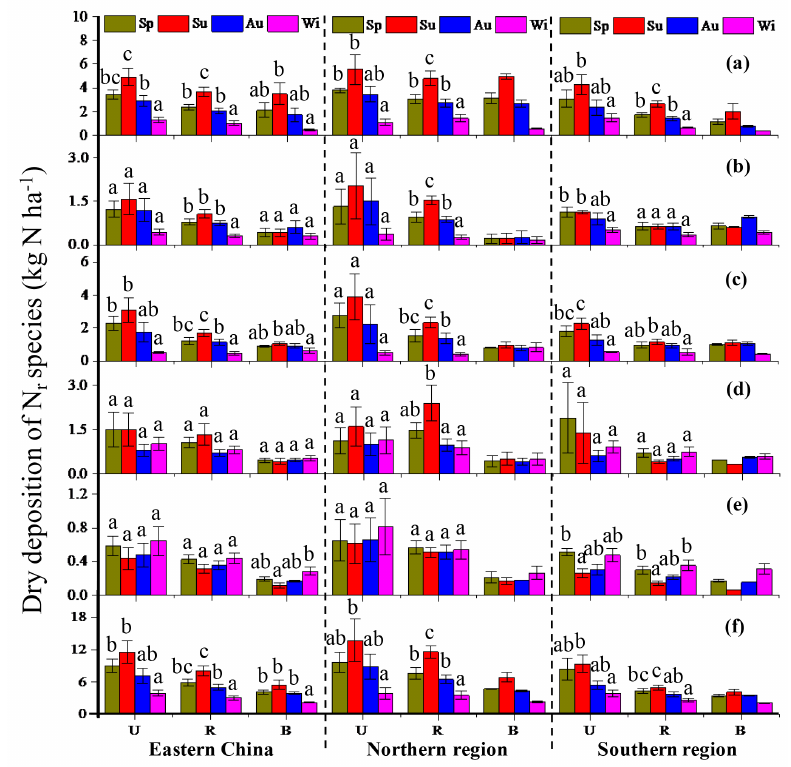
Figure 6. Seasonal mean dry deposition averaged over 2011–2015 of (a) NH 3 , (b) NO 2 , (c) HNO 3 , (d) p NH + i.e. the sum of all measured N r , in air at different land use types in eastern China and its northern and southern regions. Sp, Su, Au, and Wi represent spring, summer, autumn, and winter respectively. U, R, and B denote urban, rural, and background sites respectively. The number of sites for each land use type in each region can be found in Table 2. The error bars are the standard errors of means, and values without same letters on the bars denote significant differences between the seasons ( p